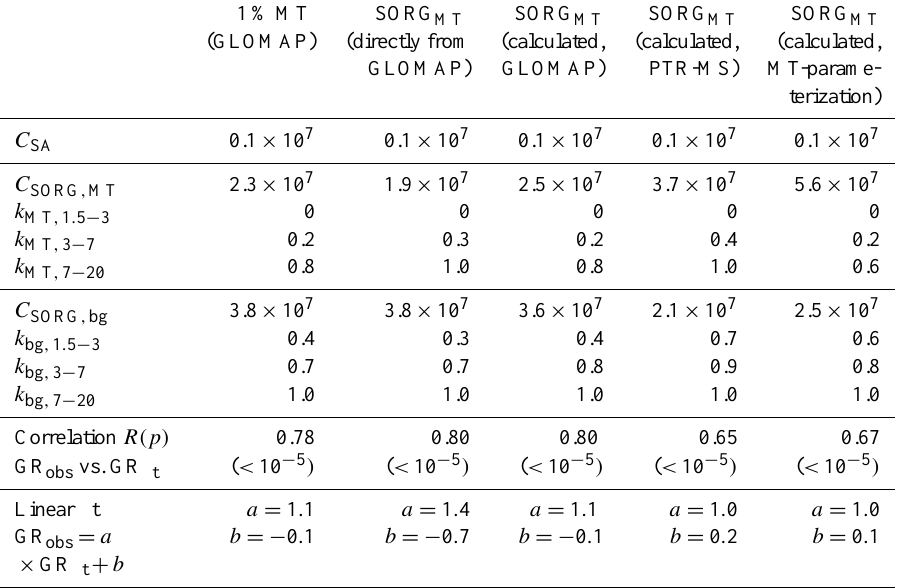
Table 3. Average concentrations of SORG MT ( C SORG , MT , cm − 3 ) and sulfuric acid ( C SA , cm − 3 ) as well as the background concentration ( C SORG , bg ,cm − 3 ) and weighing factors ( k MT and k bg ) from the mass flux fit in Hyyti¨al¨a. Differently defined concentrations of SORG MT ( I SORG , MT ) were used to test the functioning of the fit and its sensitivity to input data. Pearson’s correlation coefficients ( R ) with p values (in parentheses) and parameters a and b (nmh − 1 ), obtained from a linear fit between the observed growth rates (GR obs in nmh − 1 ) (2003–2009, monthly medians for each year) and the growth rates obtained from the mass flux fit (GR fit innmh − 1 ) are presented. 1% MT SORG MT SORG MT SORG